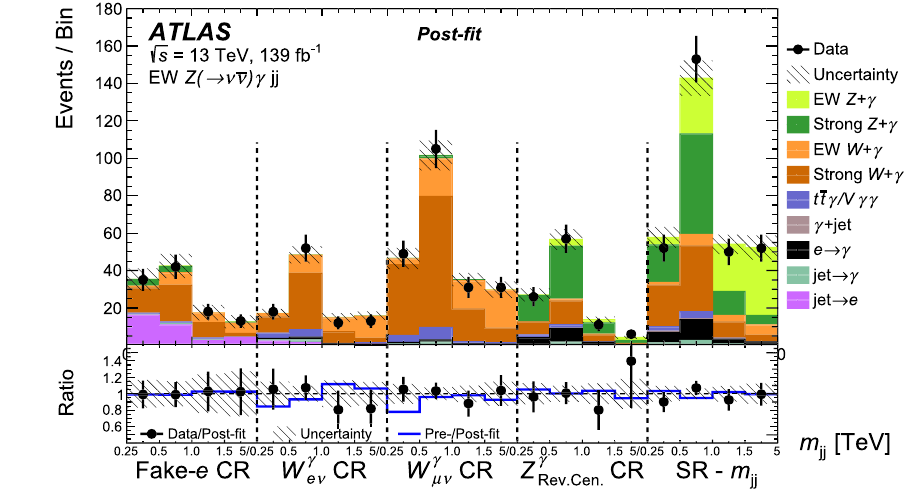
Fig. 3 Post-fit results for all m